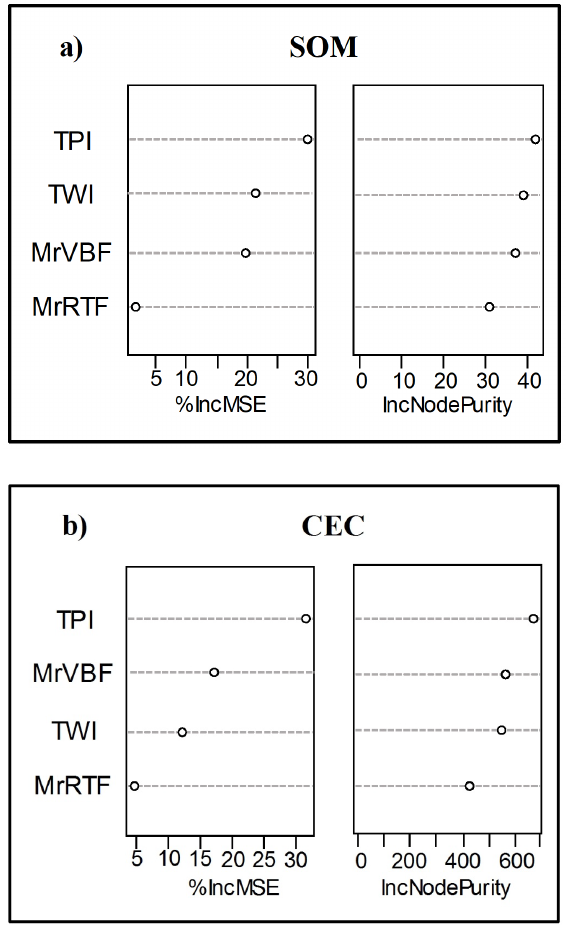
Figure 4. Random forest generated importance plots of terrain attributes, ( a ) for soil organic matter content (SOM) and ( b ) for cation exchange capacity (CEC) prediction. The %IncMSE shows the mean decrease in accuracy. The IncNodePurity shows the decrease in node purity at the end of the tree. The higher %IncMSE and IncNodePurity values show that a particular variable is highly important and if removed the prediction accuracy and node purity will be affected.